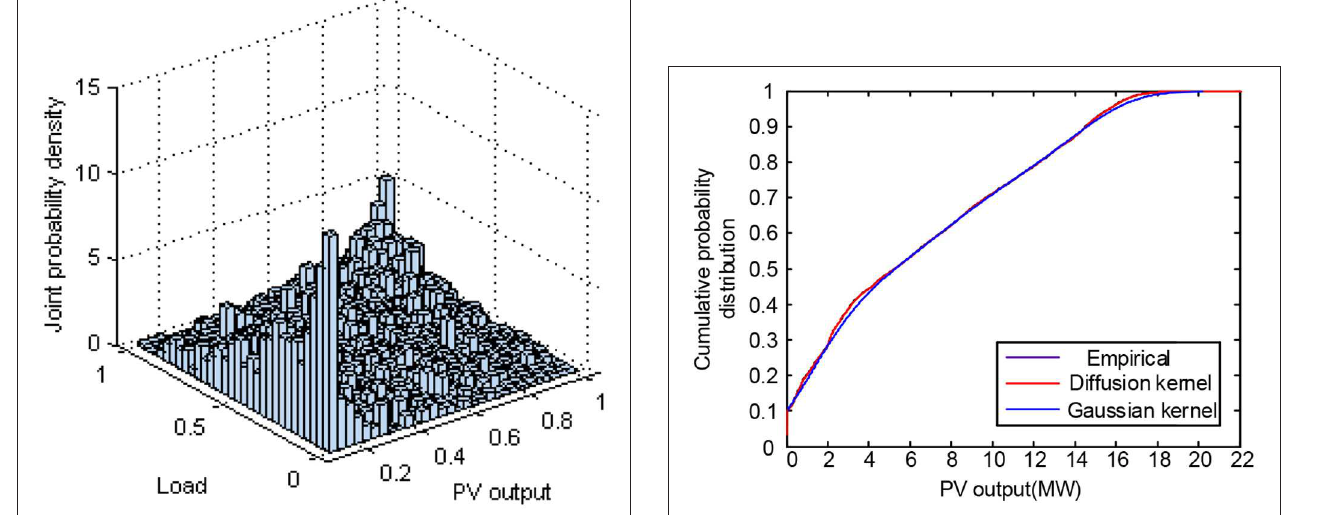
FIGURE 4 | Probability distribution of photovoltaic (PV) output.